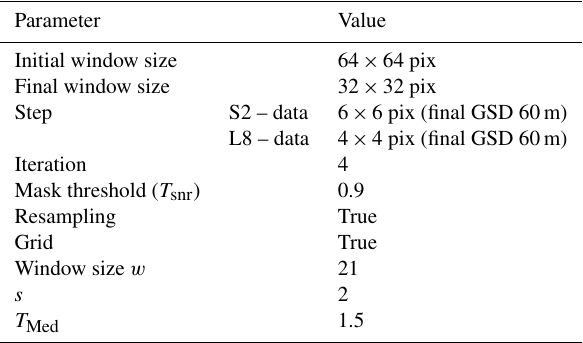
Table 2. Summary of the parameters used for image correlation and displacement